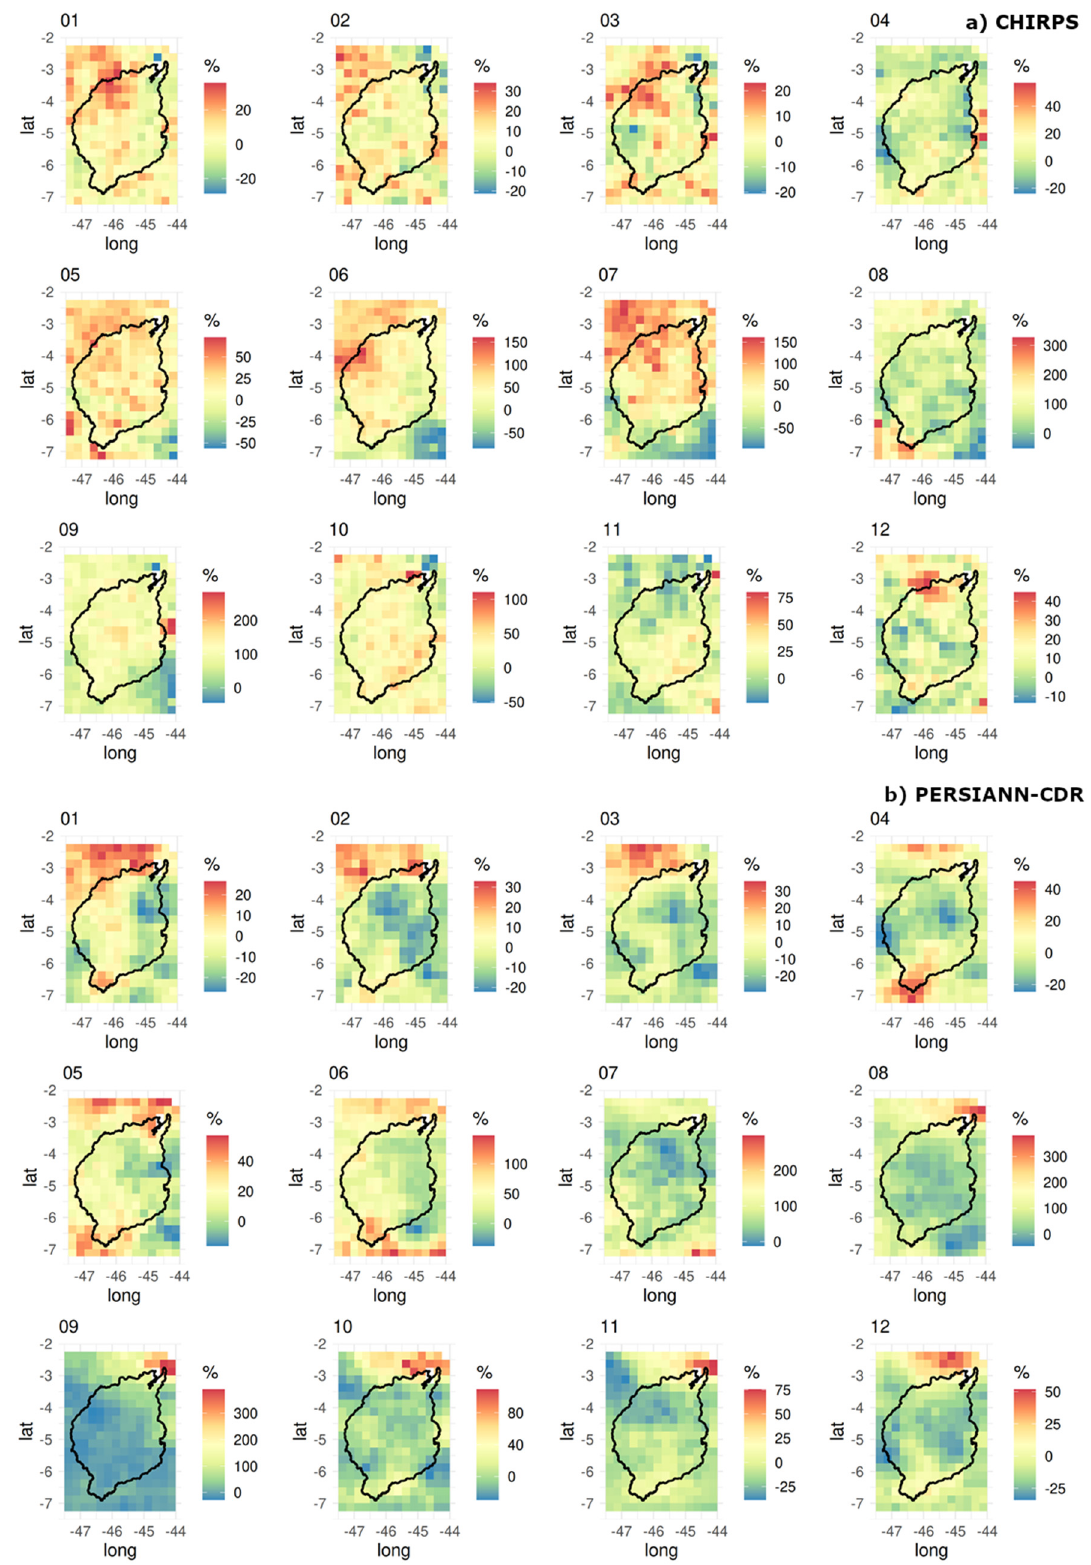
Figure 11. pbias (%) monthly rx1day (gridBR × CHIRPS ( a ) and gridBR × PERSIANN-CDR ( b )) from January (01) to December (12) 1983 to 2013. Each SRE and each month for pbias (%) have different representative scales.